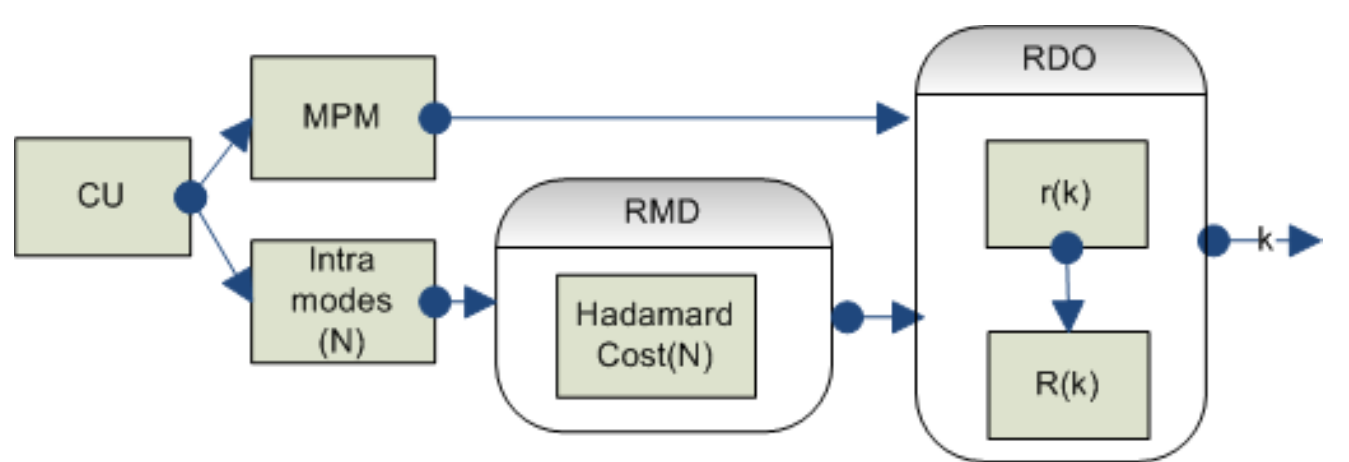
Figure 6. Block diagram of the proposed